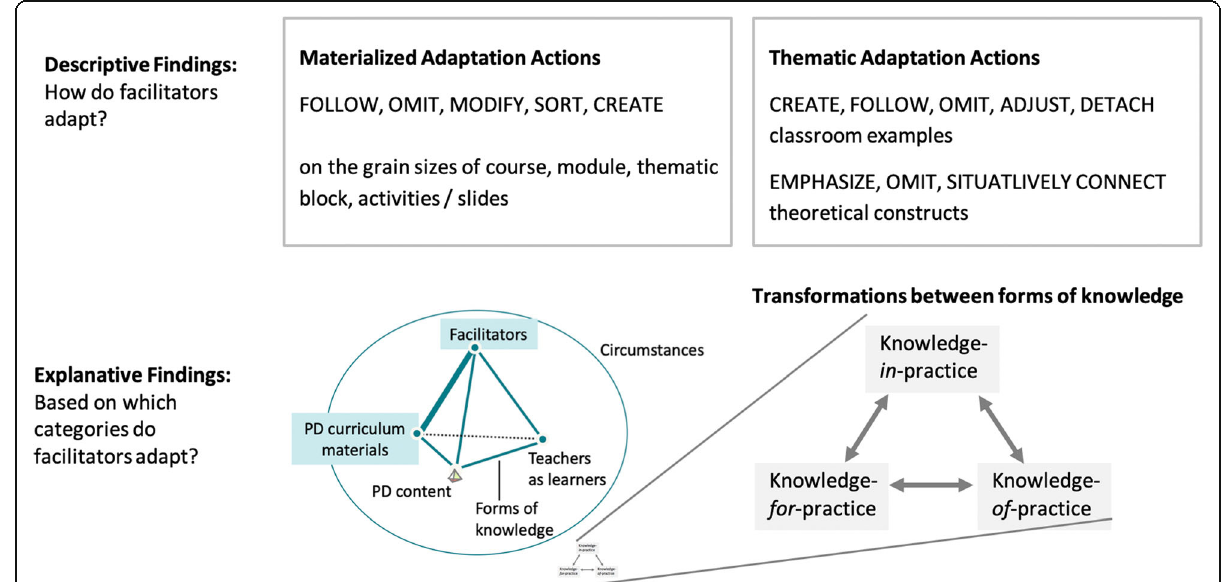
Fig. 6 Summary of frames for descriptive and explanative